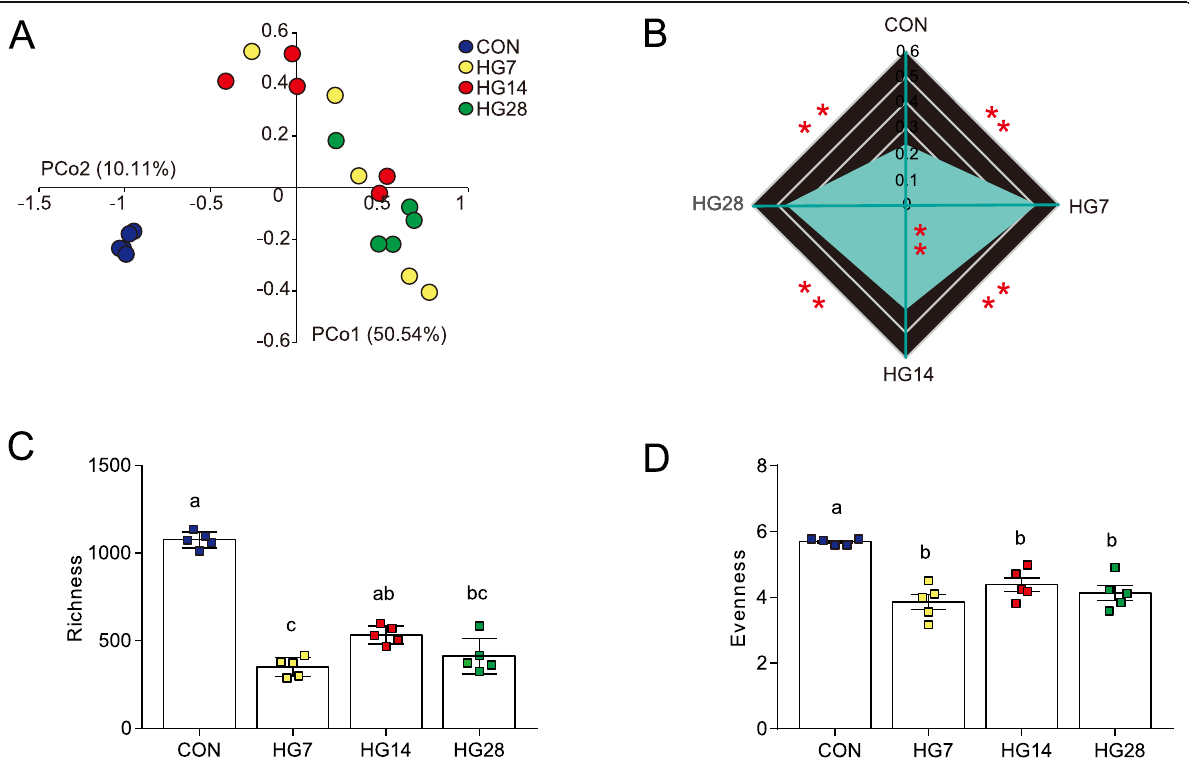
Fig. 1 (A) PCoA analysis of bacterial communities in the colonic digesta samples among 20 sheep assigned to CON ( n = 5), HG7 ( n = 5), HG14 ( n = 5), and HG28 ( n = 5) groups, which received an HG diet for 0, 7, 14, and 28 days, respectively. (B) Comparisons of the distances based on the unweighted UniFrac dissimilarity matrix among the four groups at the OTU level. * p < 0.05, ** p < 0.01. (C) The colonic bacterial richness (number of observed species) and (D) evenness (Shannon diversity index values) at the 3% dissimilarity